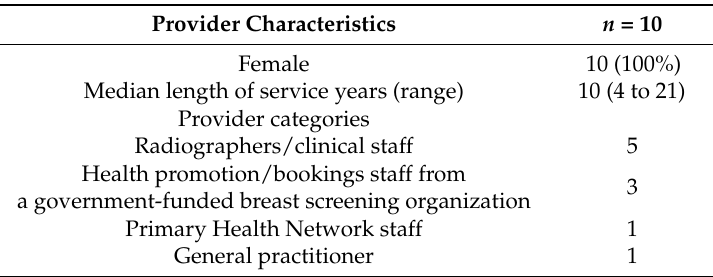
Table 2. Provider